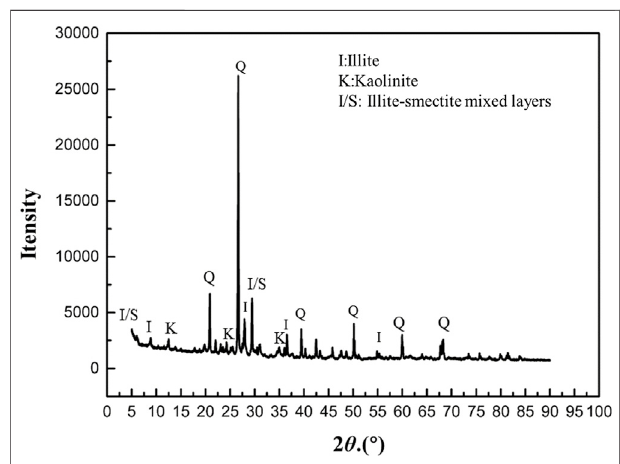
FIGURE 2 | The mineralogy of loess in Lanzhou New